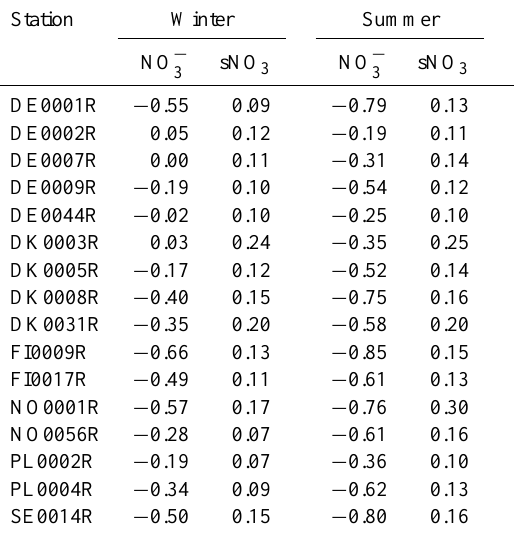
Table 5. MNB values of hourly NO − and sNO 3 concentrations in 3 the zero case with respect to the base case. Base case concentra- tions are considered as observations for the MNB calculation (see Eq. A2). Thus, positive values indicate the zero case concentrations exceed base case concentrations and negative concentrations indi- cate the